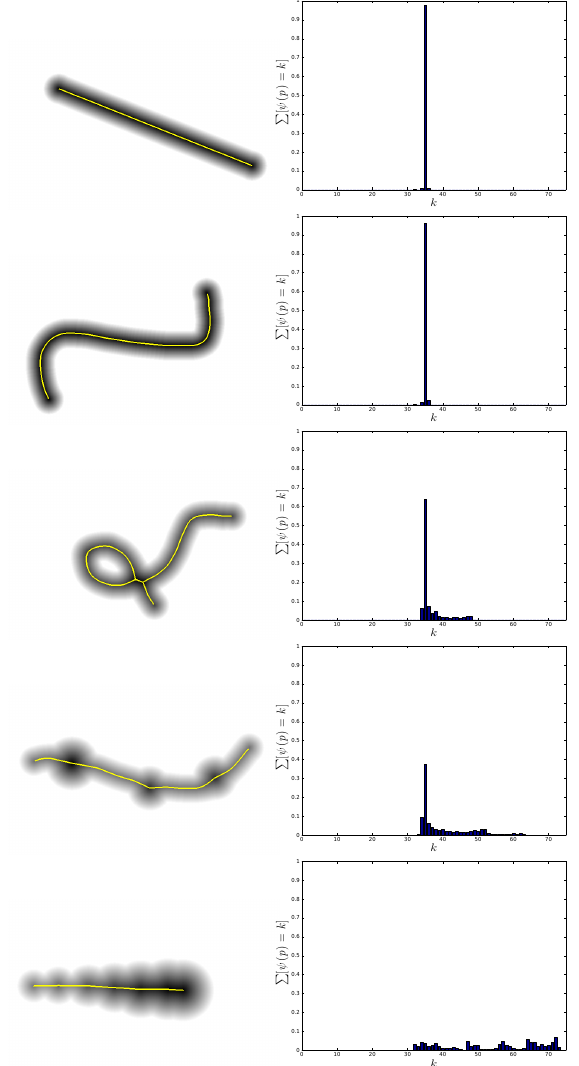
Figure 2: Histogram representation of synthetic objects with skele- ton pruning. Left the medial axis superimposed on the object, and right, the object’s histogram.